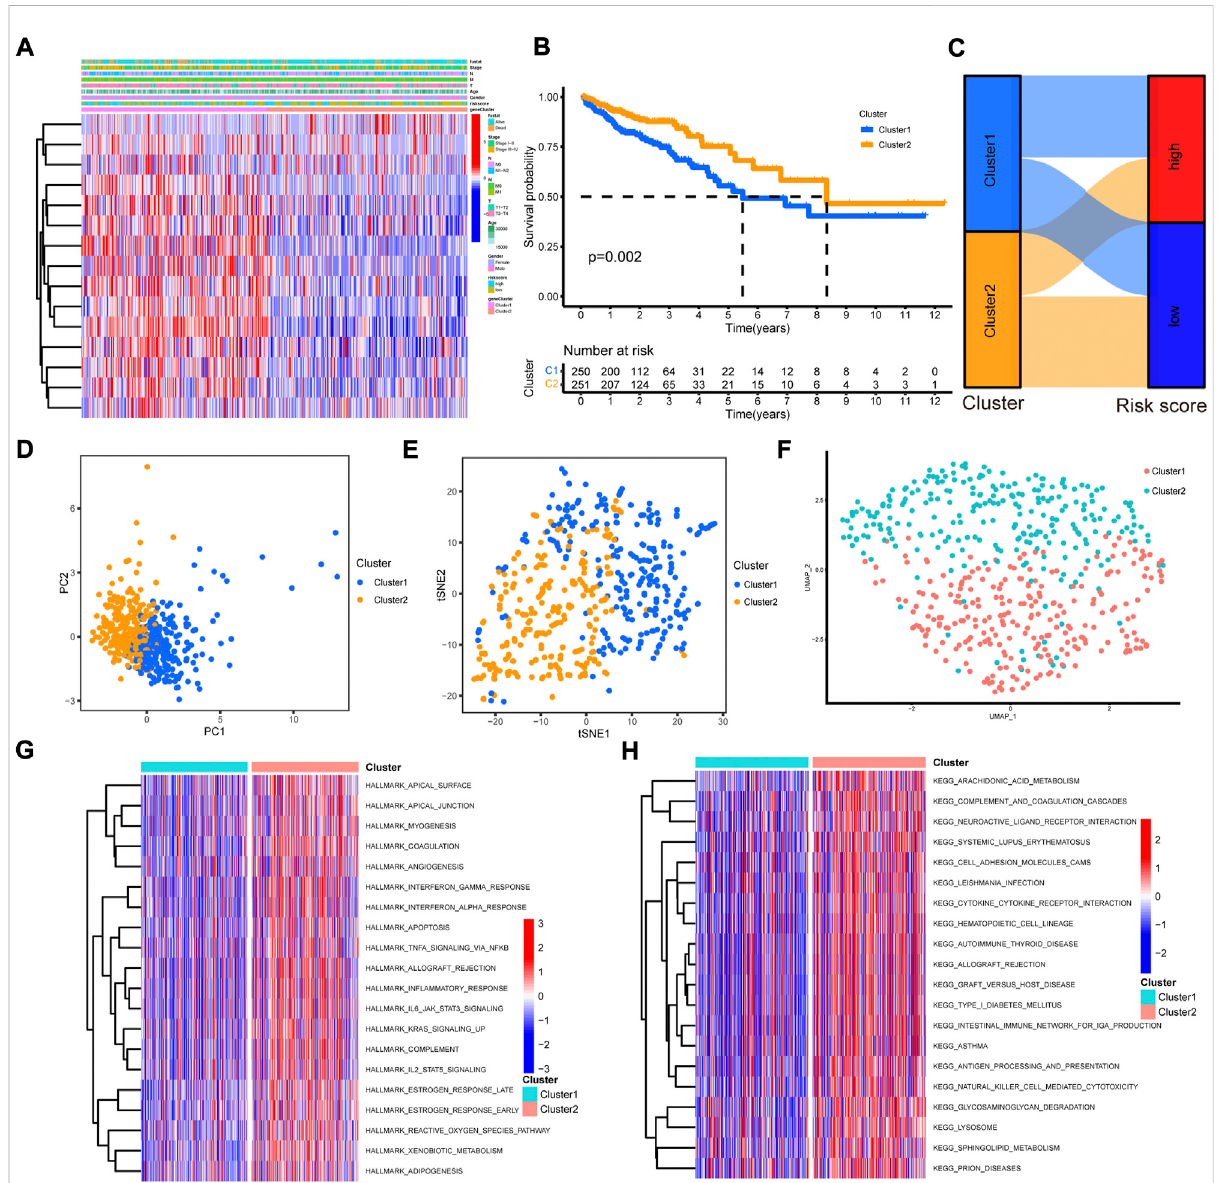
FIGURE 6 The construction and function annotation of cuproptosis-related cluster. (A) The heatmap of 15 model lncRNAs expression and clinicopathologicalfeaturesincluster1 andcluster 2. (B) The Kaplan – Meiersurvivalcurvesofoverall survivalbetweencluster1 andcluster 2. (C) The alluvialdiagramshowedtheattributechangesfromriskscoretoclustersubtype. (D) ThePCAofthetwoclusters. (E) Thet-SNEofthetwoclusters. (F) The uMAP analysis of the two clusters. (G) The heatmap of GSVA with hallmark sets between the two clusters. (H) The heatmap of GSVA with KEGG sets between the two